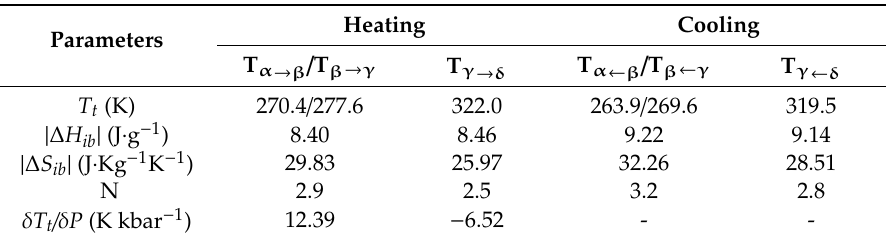
Table 1. Summary of thermodynamic parameters for the phase transitions of TMACdN 3 compound obtained from DSC analysis under heating and cooling. | ∆ H ib | is the isobaric enthalpy change, | ∆ S ib | is the isobaric entropy change, N is the number of sites in the disordered phase and δ T t / δ P is the barocaloric coe ffi